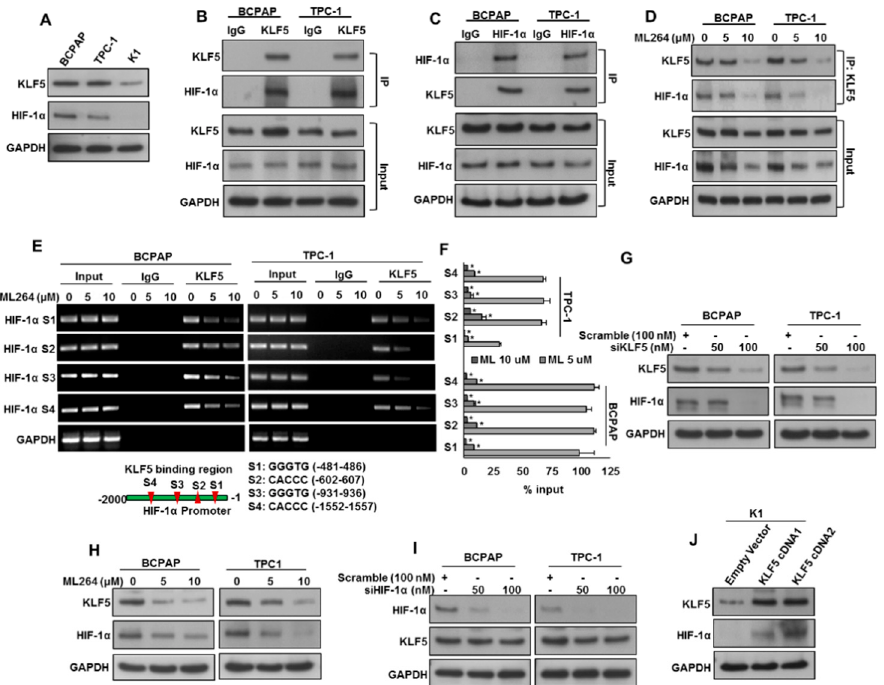
Figure 2. KLF5 is a functional upstream of HIF-1 α . ( A ) Basal expression of KLF5 and HIF-1 α in PTC cell lines. Proteins were isolated from three PTC cell lines and immunoblotted with antibodies against KLF5, HIF-1 α and GAPDH. ( B ) KLF5 interact with HIF-1 α . Cell lysates extracted from PTC cells were immunoprecipitated with KLF5 or IgG antibody. Interaction of endogenous KLF5 and HIF-1 α was detected by immunoblotting. ( C ) HIF-1 α interact with KLF5. Cell lysates extracted from PTC cells were immunoprecipitated with HIF-1 α or IgG antibody. Interaction of endogenous KLF5 and HIF-1 α was detected by immunoblotting. ( D ) ML264 disrupts the physical interaction of KLF5 and HIF-1 α in PTC cells. PTC cells were treated with indicated doses of ML264 for 6 h. Cell lysates extracted from PTC cells were immunoprecipitated with KLF5 antibody. Interaction of endogenous KLF5 and HIF-1 α was detected by immunoblotting. ( E , F ) KLF5 binding to HIF-1 α promoter. For the ChIP assay, the KLF5-binding regions on HIF-1 α promoter were identified. PTC cells were treated with and without ML264 (5 and 10 µ m) for 6 h, fixed with formaldehyde, and cross-linked, and then chromatin was isolated. The chromatin was immunoprecipitated (IP) with an anti-KLF5 antibody or control mouse IgG. The KLF5 binding to the HIF-1 α promoters was analyzed by regular PCR ( E ) or quantitative real-time PCR ( F ) with a primer specific to the KLF5-binding regions in HIF-1 α promoter. The data represent the percent input and are normalized to each control. GAPDH was used as a loading control. ( G ) Silencing of KLF5 inhibits HIF-1 α . PTC cells were transfected with scrambled siRNA and KLF5 siRNA (50 and 100 nM). After 48 h, cells were lysed and proteins were immunoblotted with antibodies against KLF5, HIF-1 α and GAPDH. ( H ) ML264 treatment down-regulates the expression of KLF5 and HIF-1 α in PTC cells. PTC cells were treated with indicated doses of ML264 for 48 h. After cell lysis, equal amounts of proteins were separated by SDS-PAGE, transferred to immobilon membrane, and immuno-blotted with antibodies against KLF5, HIF-1 α and GAPDH as indicated. ( I ) Knockdown of HIF-1 α has no effect on KLF5 expression. PTC cells were transfected with scrambled siRNA and HIF-1 α siRNA (50 and 100 nM). After 48 h, cells were lysedand proteins were immunoblotted with antibodies against HIF-1 α , KLF5 and GAPDH. ( J ) Forced expression of KLF5 increases HIF-1 α expression. K1 cells were transfected with either empty vector or KLF5 cDNA for 48 h. Proteins were isolated and immunoblotted with antibodies against KLF5, HIF-1 α and GAPDH for equal loading. Data presented in the bar graphs are the mean ± SD of triplicates in an independent experiments, which was repeated for at least two times with the same results. * Indicates a statistically significant difference compared to control with p < 0.05. Western blot experiments were repeated at least two times with the same